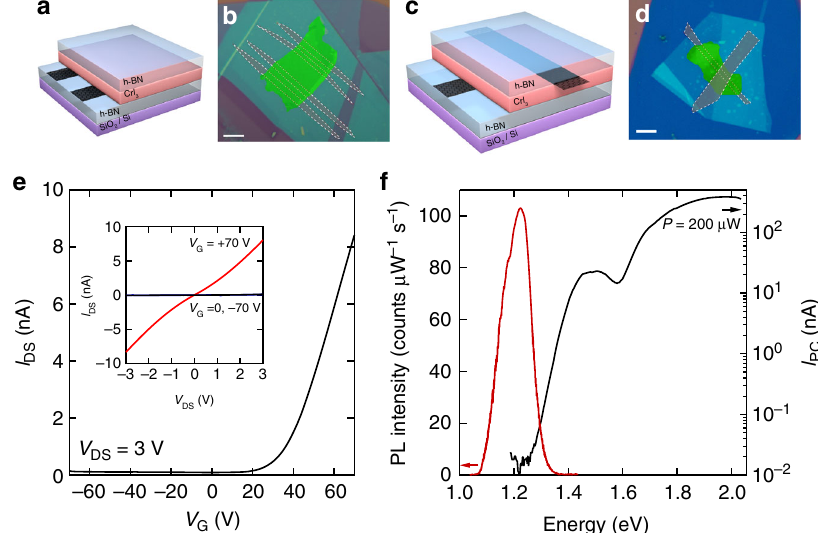
Fig. 1 Semiconducting characteristics of CrI 3 . Scheme ( a ) and false-color optical micrograph ( b ) of a CrI 3 fi eld-effect transistor realized using few-layer graphene contacts, encapsulated between hexagonal boron nitride (hBN) crystals. The highly doped Silicon substrate covered by a 285 nm SiO 2 layer is used as gate (the scale bar in b is 5 µ m long). Scheme ( c ) and false-color optical micrograph ( d ) of a heterostructure consisting of bottom and top multilayer graphene contacts attached to an exfoliated CrI 3 crystal ~7 nm thick (the entire structure is encapsulated between hBN crystals; the scale bar in d is 5 µ m long). e Transfer characteristics of the fi eld-effect transistor shown in b measured at room temperature with V DS = 3 V applied between the two multilayer graphene contacts. The transistor turns on for positive gate voltage indicating electron conduction. The inset shows the source-drain current